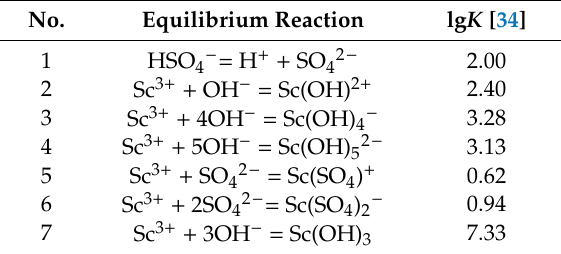
Table 1. Equilibrium reactions and thermodynamic constant of the Sc-S-H 2 O system at 298